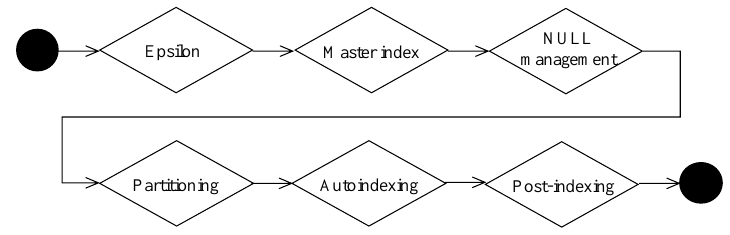
Figure 24. Whole system modularization.